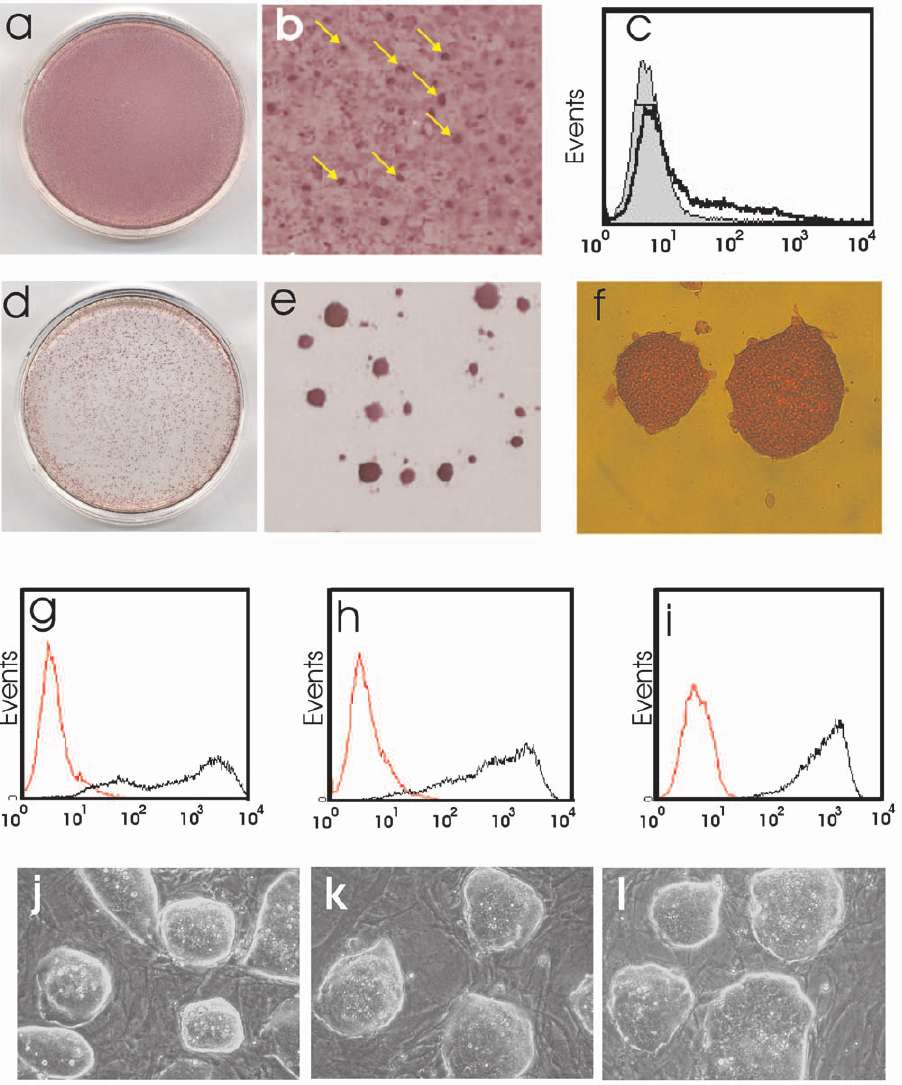
Figure 7. Non-clonal selection of iPS cells with UTF-Neo. Cultures of TiB7-4 iPS cells at passage 11 show flat growing cells with varying expressions of alkaline phosphatase ( a ) and contain clusters of cells that stain strongly for alkaline phosphatase (arrows) ( b ). When assayed for the expression of SSEA1 ( c ) the total amount of SSEA1 expressing cells was determined as 16% (black line). After transfection with UTF-Neo and selection on gelatine with 6 mg/ml G418 the flat growing cells vanish and sharp colonies with strong alkaline phosphatase ( d,e,f ) expression remain. Embryonic stem cells line Bruce4 (passage 26) displayed 84% SSEA1 positive cells (black line, g ). UTF-Neo selected cells on feeder displayed 93% SSEA1 positive cells ( h ). UTF-Neo selected cells under continuous selection pressure on gelatine contained 99% SSEA1 positive cells with high expression of the surface marker ( i ). Colony morphology of Bruce4 ES cells ( j ) and UTF-Neo selected cells ( k,l ) were compared by phase contrast microscopy.